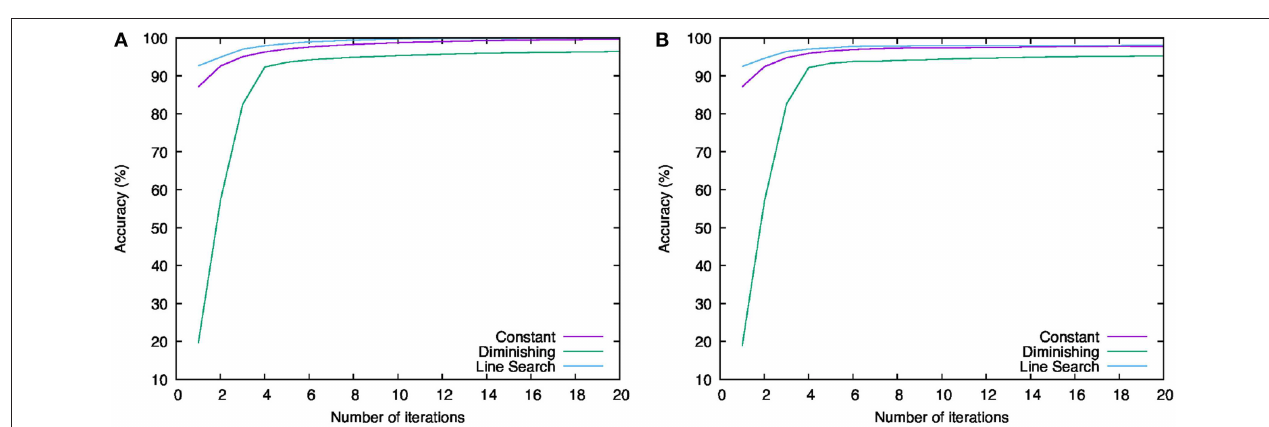
FIGURE 5 | Behavior of the classification accuracies for training and test data. (A) Result for training data. (B) Result for test data.